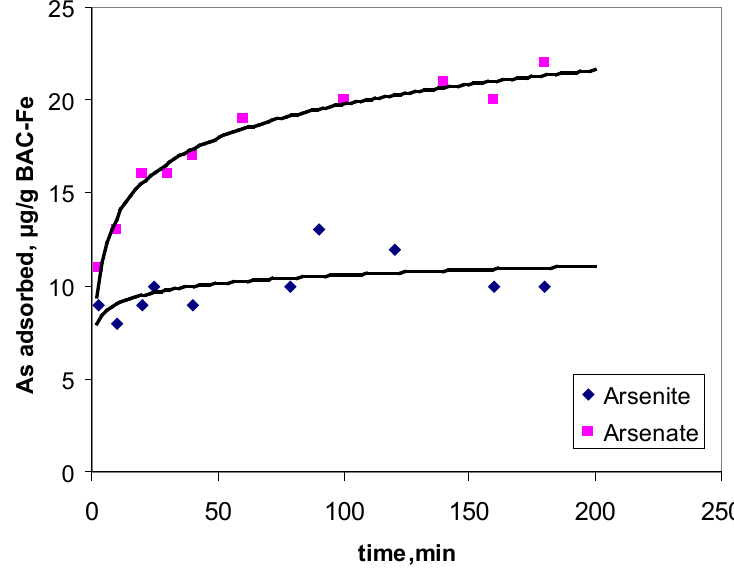
Figure 9. Kinetics of adsorption of arsenate and arsenite. Experimental conditions: 100 μg L -1 arsenite and arsenate, pH: